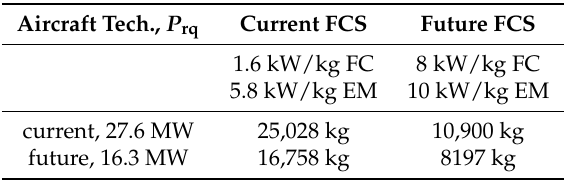
Table 2. Comparison of fuel cell system weight of current and future aircraft technology employing current and future fuel cell and electric motor (EM)